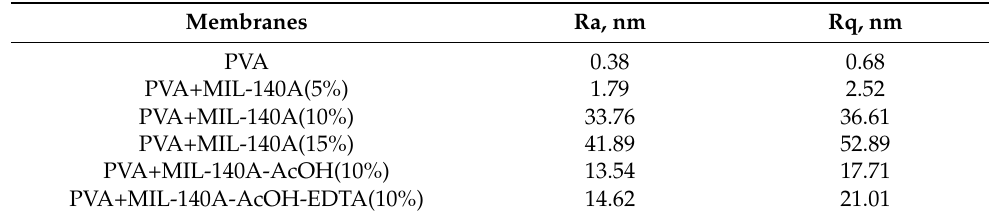
Table 1. The values of surface average (Ra) and root-mean-squared (Rq) roughness of the uncross- linked PVA and PVA/Zr-MOFs membranes.